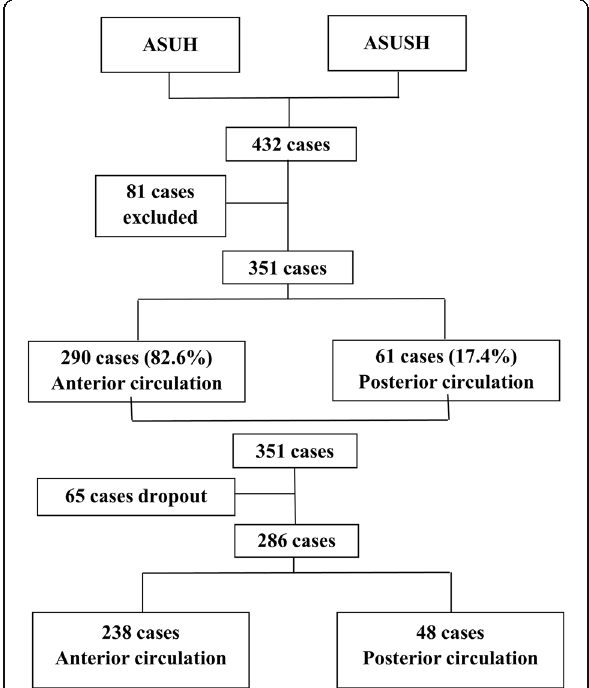
Fig. 1 The process of cases